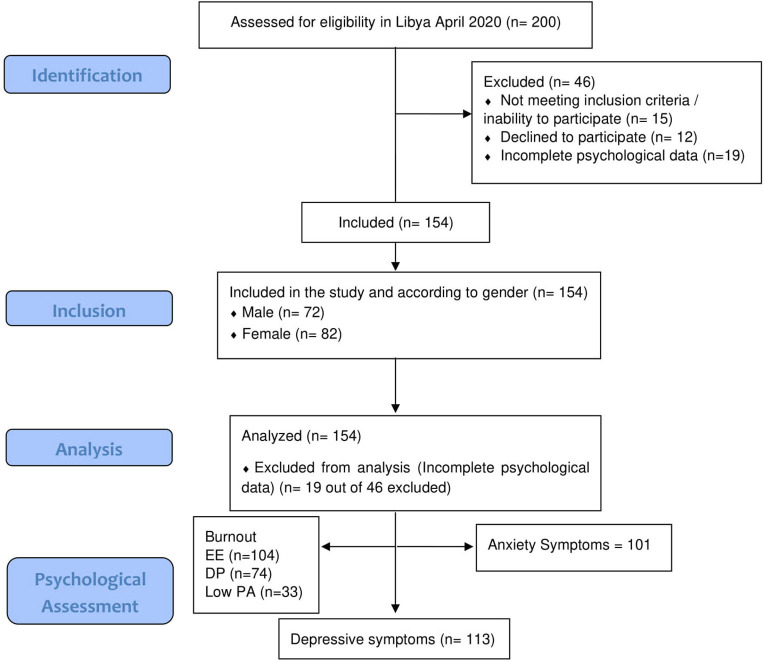
STROBE flowchart. STROBE, Strengthening the Reporting of Observational Studies in Epidemiology.